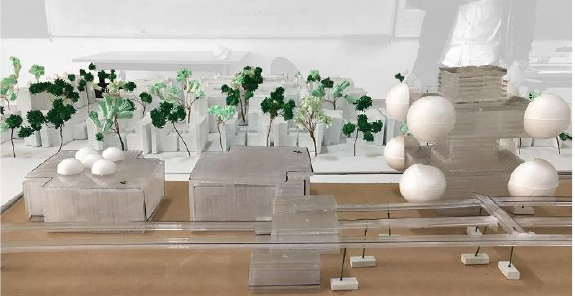
Figure 9. In the foreground is the final model of Tejas Nirula. Photo